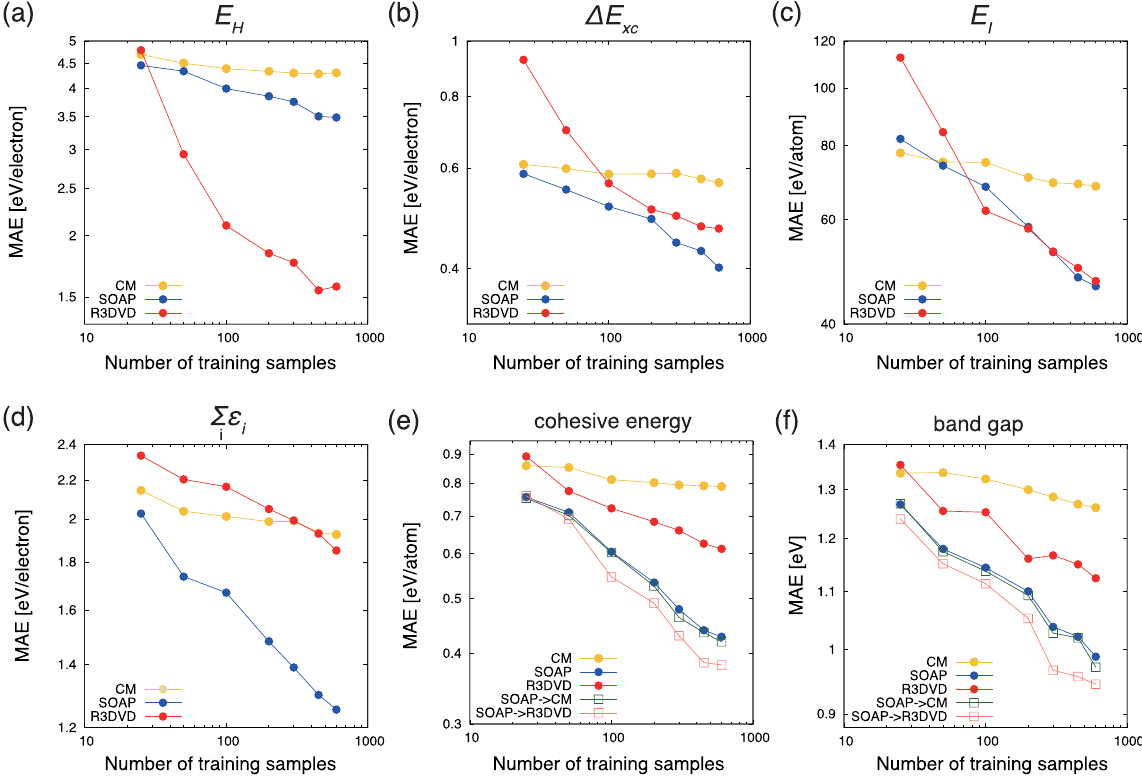
Figure 4. Mean absolute errors of R3DVS, SOAP and CM regressions of ( a ) Hartree energy (classical electron- electron electrostatic energy), ( b ) exchange-correlation energy term (see Eq. (5)), ( c ) electrostatic energy of ion cores, ( d ) sum of the one-electron orbital energies, ( e ) cohesive energy, and ( f ) band gap. The horizontal axis indicates number of the training samples, which do not count the rotated